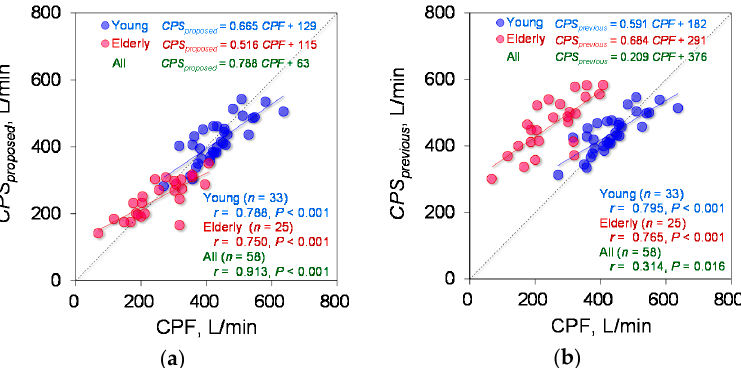
Figure 4. Estimation accuracy of CPS proposed and CPS previous . ( a ) The CPF estimated by the proposed model ( CPS proposed ) against the measured CPF. ( b ) Plot of the CPF estimated by the previous model ( CPS previous ) against the measured CPF. The red and blue circles represent the elderly and young participants, respectively. The linear regression lines are drawn for the groups of young and elderly participants, and the corresponding equations are shown in the upper part of each figure, where the green letters indicate the equation of the regression line for all participants. The right lower side shows the correlation coefficients and P values for each participant group.